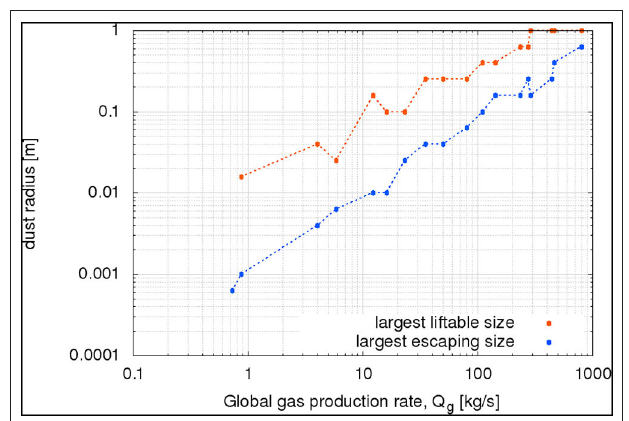
FIGURE 8 | The ratio of dust mass falling back, Q D shown as a function of global gas production rate for different power-law exponents.